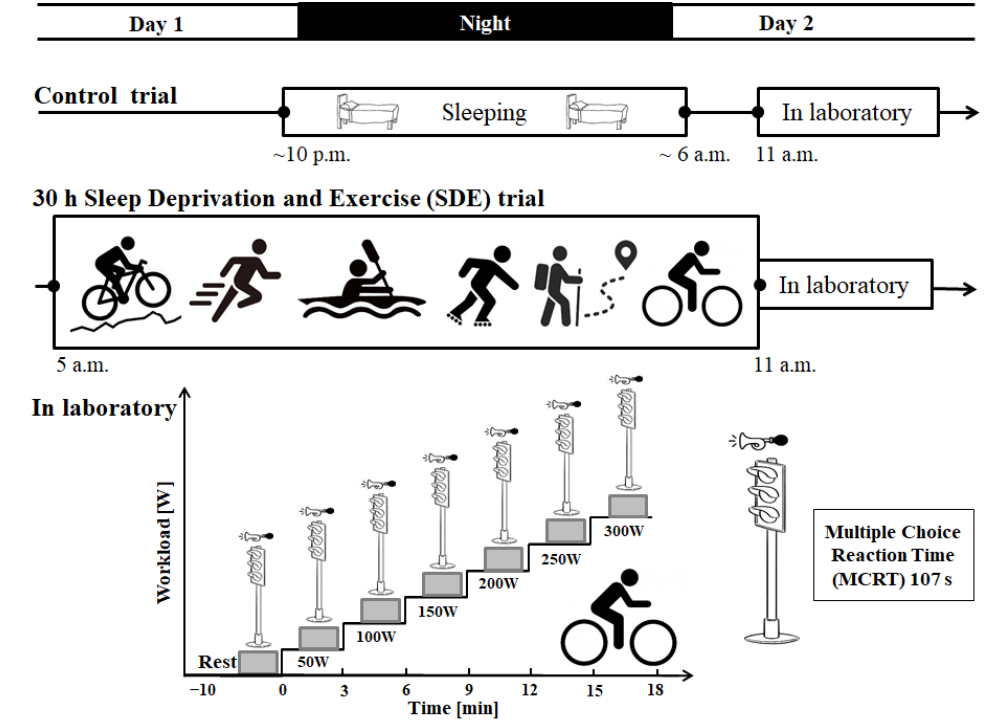
Figure 1. The block diagram of the experiment.